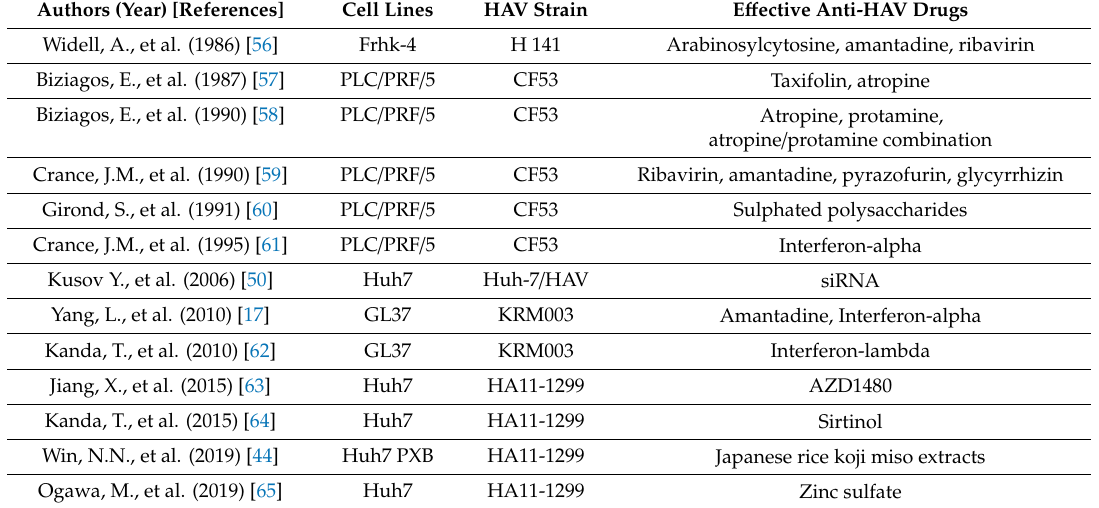
Table 2. E ff ective drugs inhibiting hepatitis A virus (HAV) replication discovered in cell culture systems for